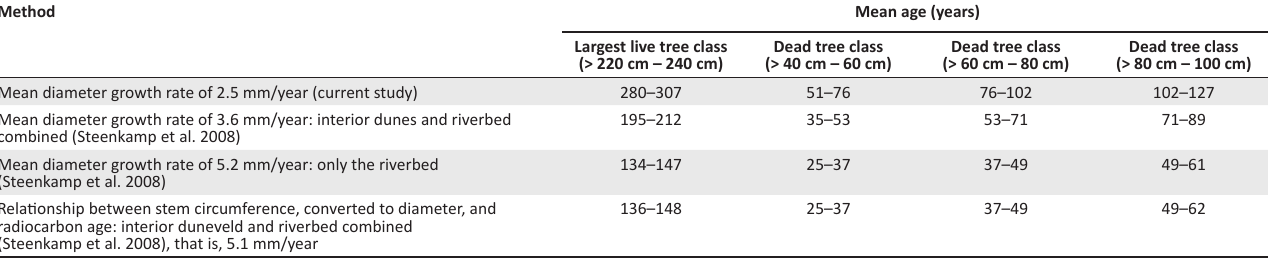
Mean diameter growth rate of 5.2 mm/year: only the riverbed (Steenkamp et al. 2008)